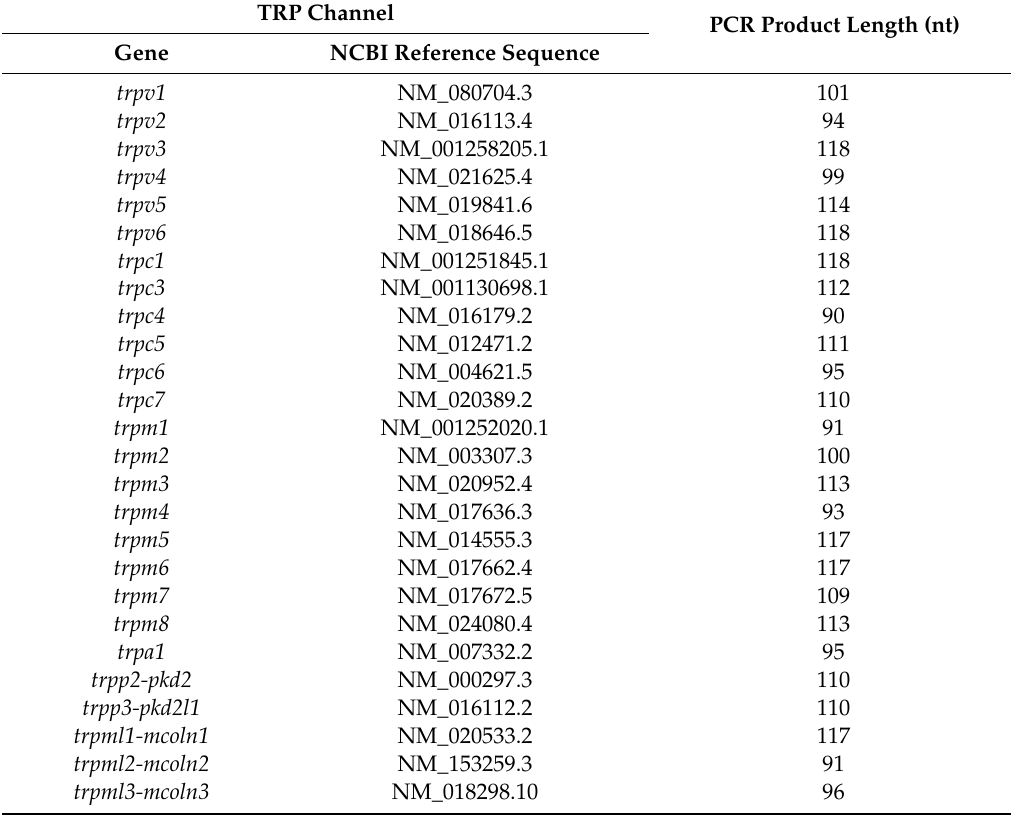
Table 1. Primers for trp channels were designed on the functional region of the channels. Primer3 was used to select the best primer couple for each gene. Primer couples were chosen in order to detect all functional variants described in